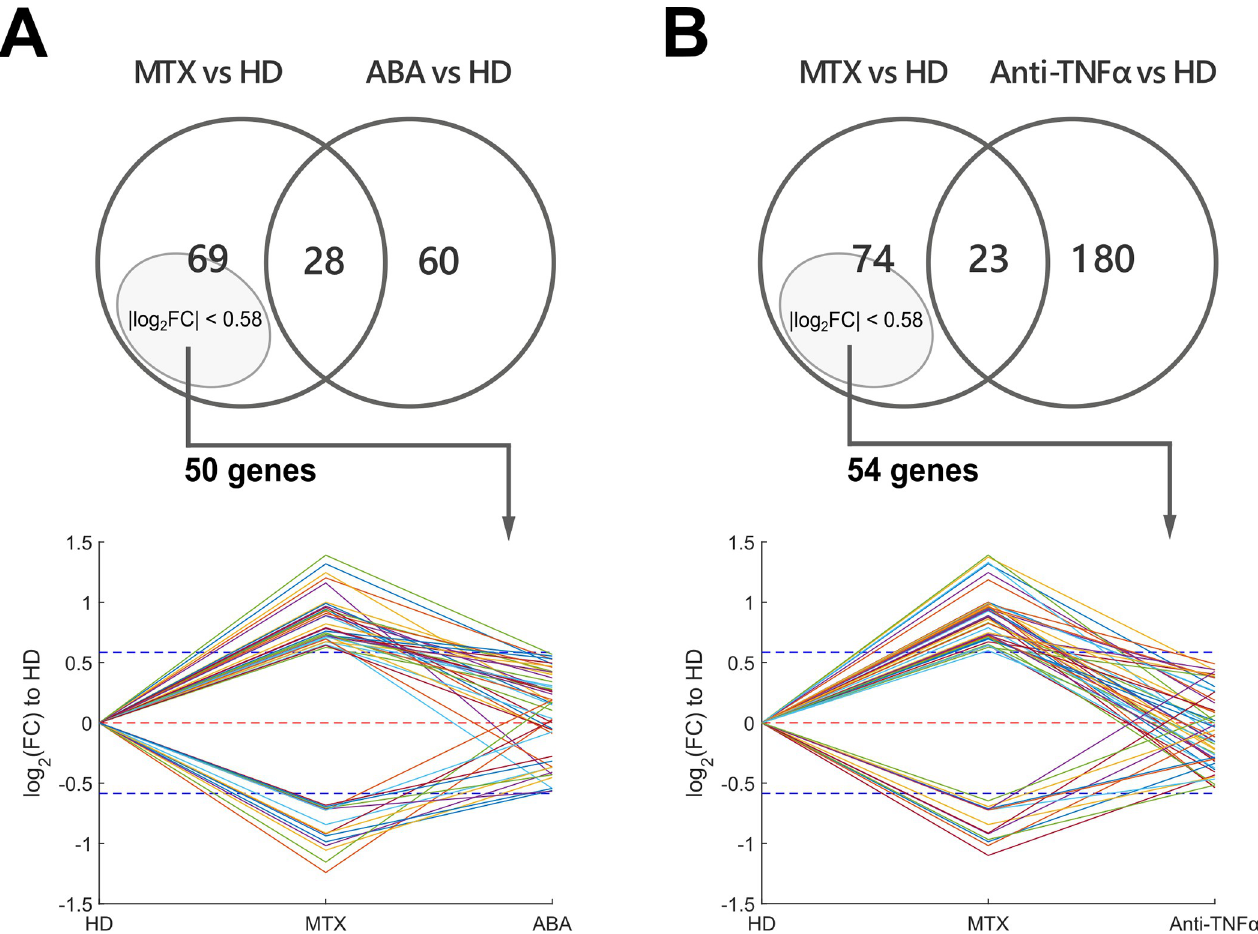
Fig 6. Genes reverted after bDMARD administration. Genes significantly up- and down- regulated by methotrexate (MTX) versus healthy donors (HD) were crossed with genes modulated by abatacept (ABA) and anti-TNF α compared to HD group. (A) For abatacept-treated patients, 69 genes were found to be significantly dysregulated in MTX-treated patients but not after bDMARD administration (left set of the Venn diagram). Among them, only those 50 genes showing a 0.6667 < FC < 1.5 (|log 2 FC| < 0.58) in ABA compared to HD group were deemed to be reverted by abatacept and their log 2 FCs across the different groups are shown using HD as reference. (B) The same procedure applied to detect genes reverted by anti-TNF α .